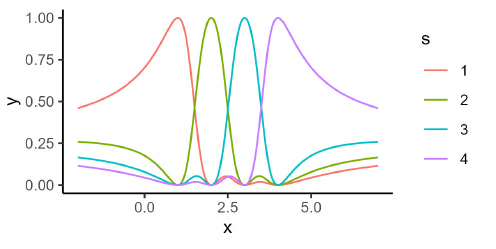
( s ) for s ∈ S = { 1,2,3,4 } and x ∈ [ − 2,7 ] on ( R , | · | ) . Figure 3. The values of d µ x d µ